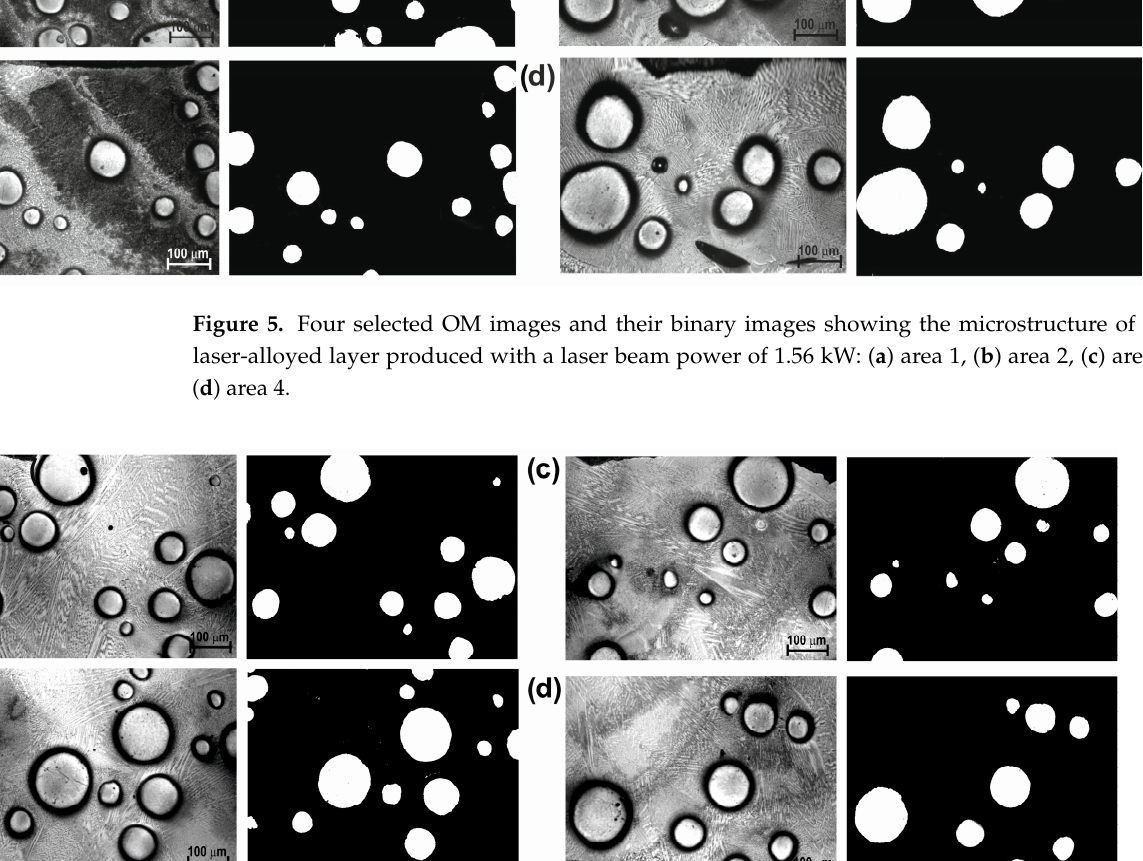
Figure 6. Four selected OM images and their binary images showing the microstructure of the la- ser-alloyed layer produced with a laser beam power of 1.82 kW: ( a ) area 1, ( b ) area 2, ( c ) area 3, ( d ) area 4. Table 2. Percentage of WC particles in the laser-alloyed layers enriched with WC particles.